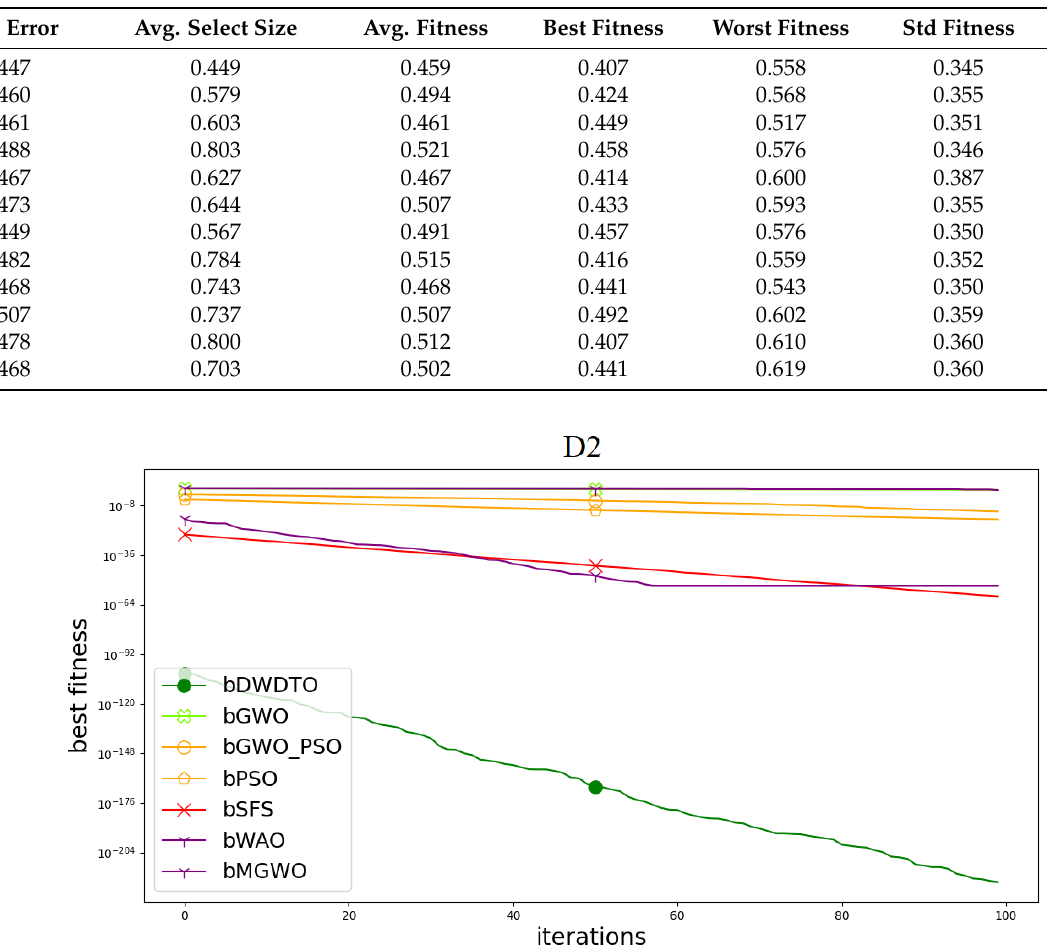
Table 9. Evaluation results of the feature selection results achieved by the proposed and other competing algorithms when applied to the second dataset (D2).